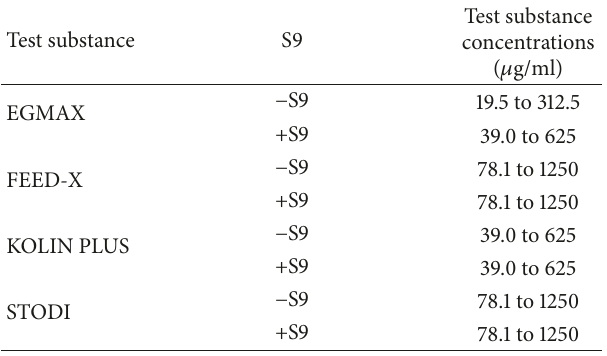
Table 2: Concentrations of test substances selected for main mutagenicity